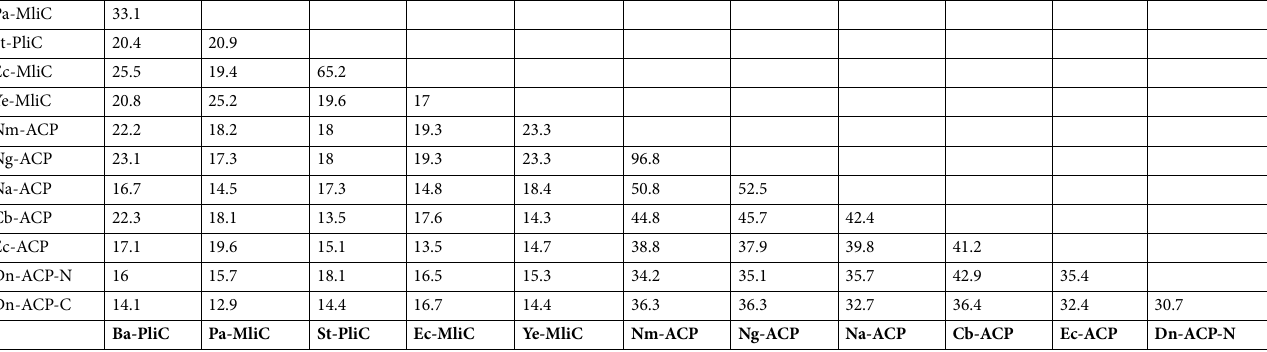
Table 1. Sequence identities for ACP and MliC/PliC domains as determined from the sequence alignment shown in Fig. 1.